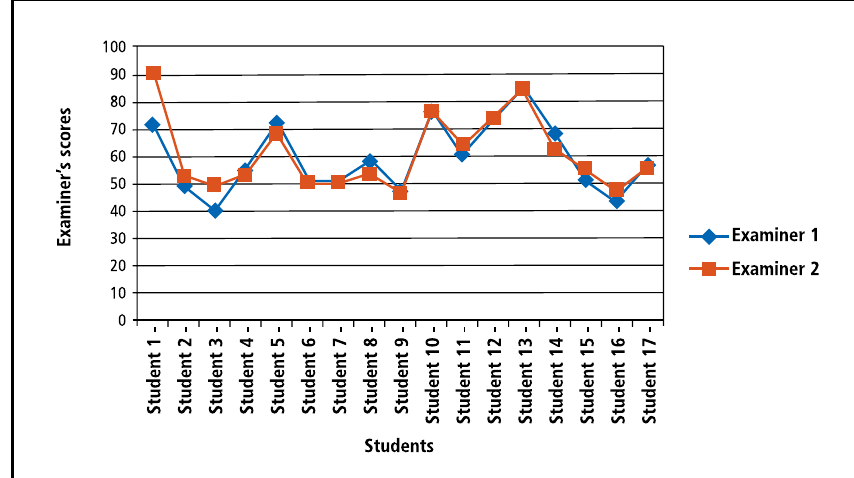
figure 1: Treatment examination totals